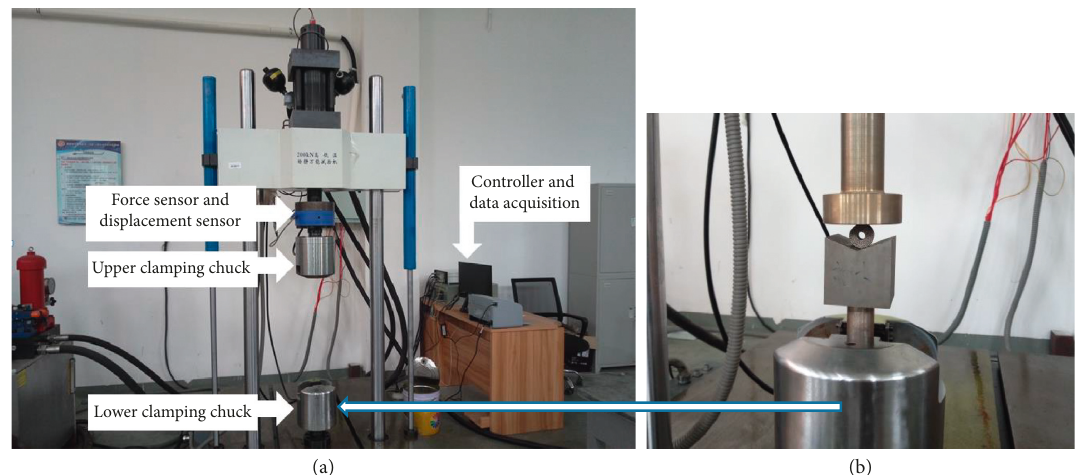
Figure 5: Dynamic (a) and static (b) material testing machine used in the present